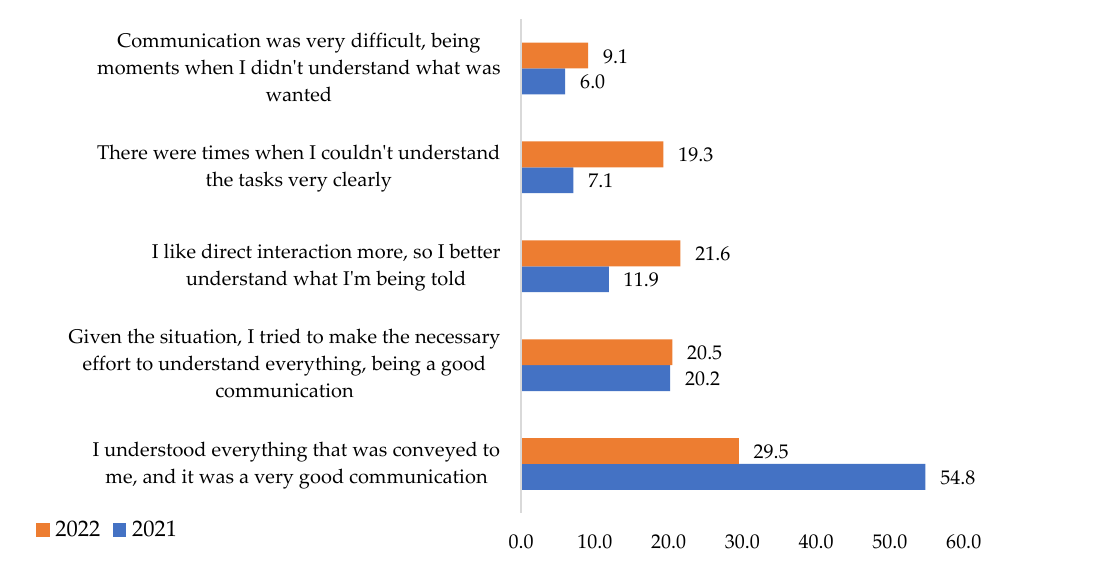
Figure 9. Staff worker’s quality connection. Source: Data from field quizzes, 2021, 2022.